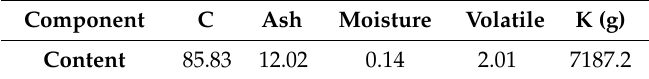
Table 3. The composition of the coking coal (wt